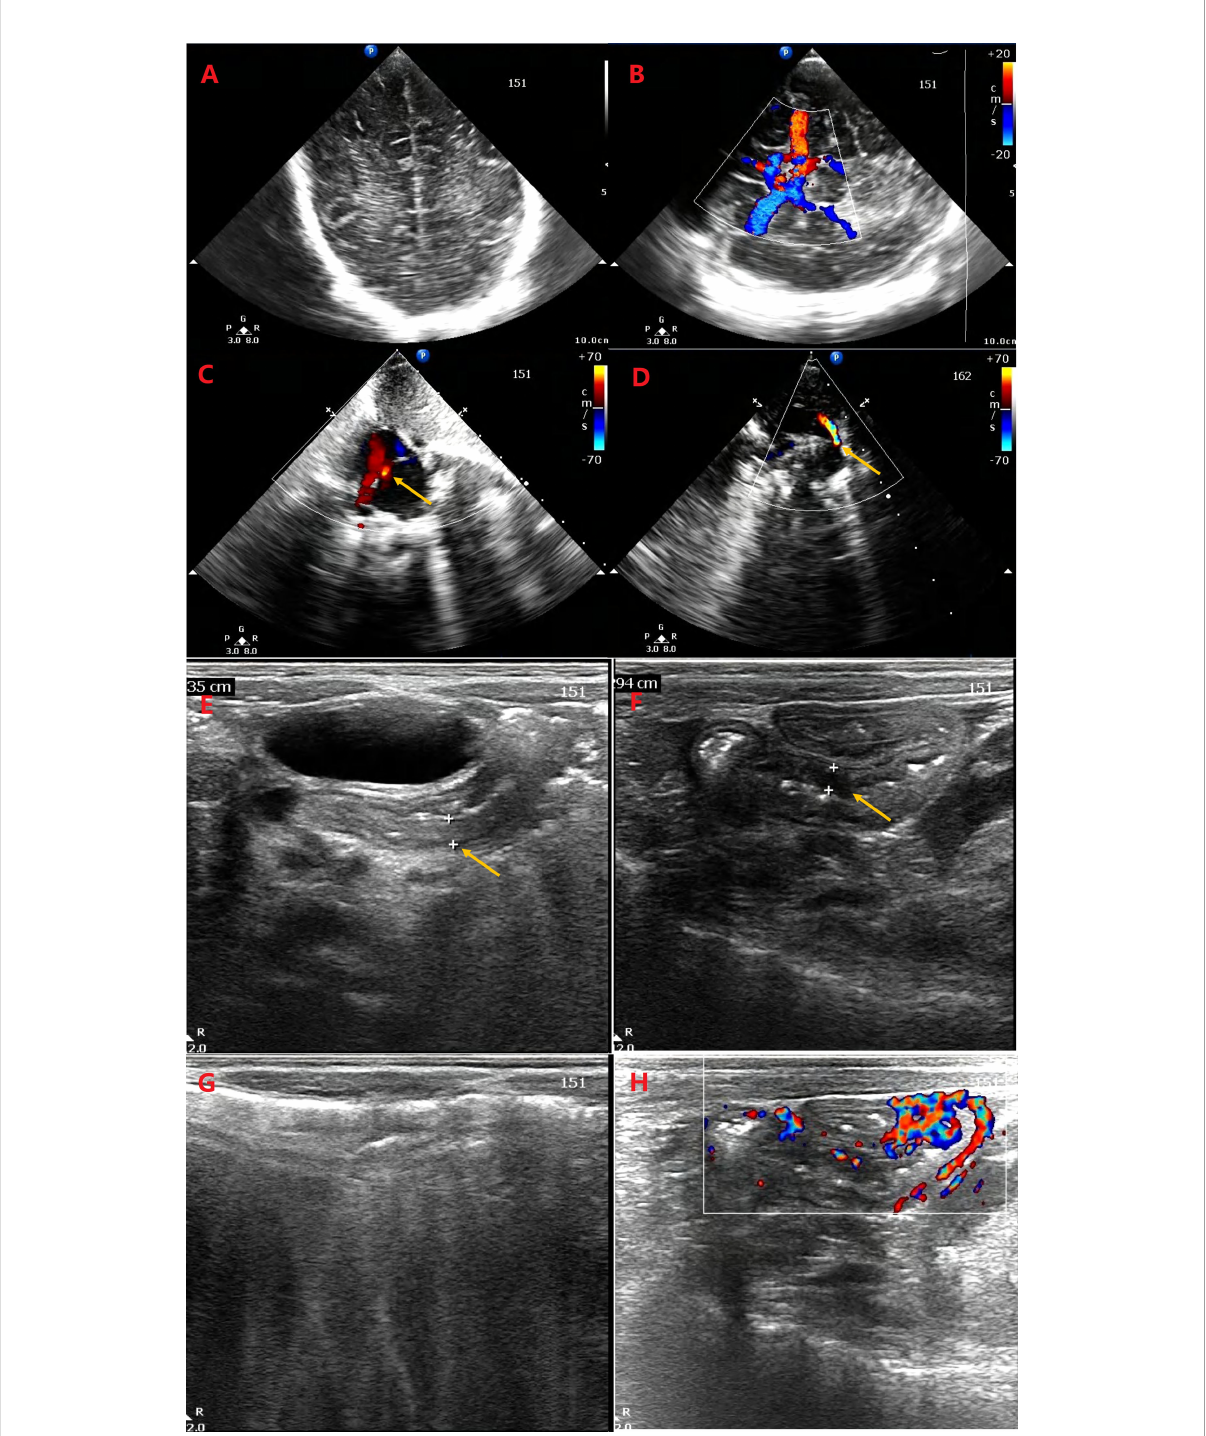
FIGURE 2 Ultrasonic Doppler resolution is applied for detecting the abdomen, heart, and brain. No obvious abnormality was detected on the brain sonogram (A, B) . The patent ductus arteriosus (D) and patent foramen ovale (C) were found. There are partial bowel fl atulence of epigastrium, partial intestinal thickening of colon (0.335 cm, 0.294 cm) (E, F) , and a little of seroperitoneum. Intestinal gassiness (G) and blood fl ow in thickened intestinal wall (H) were